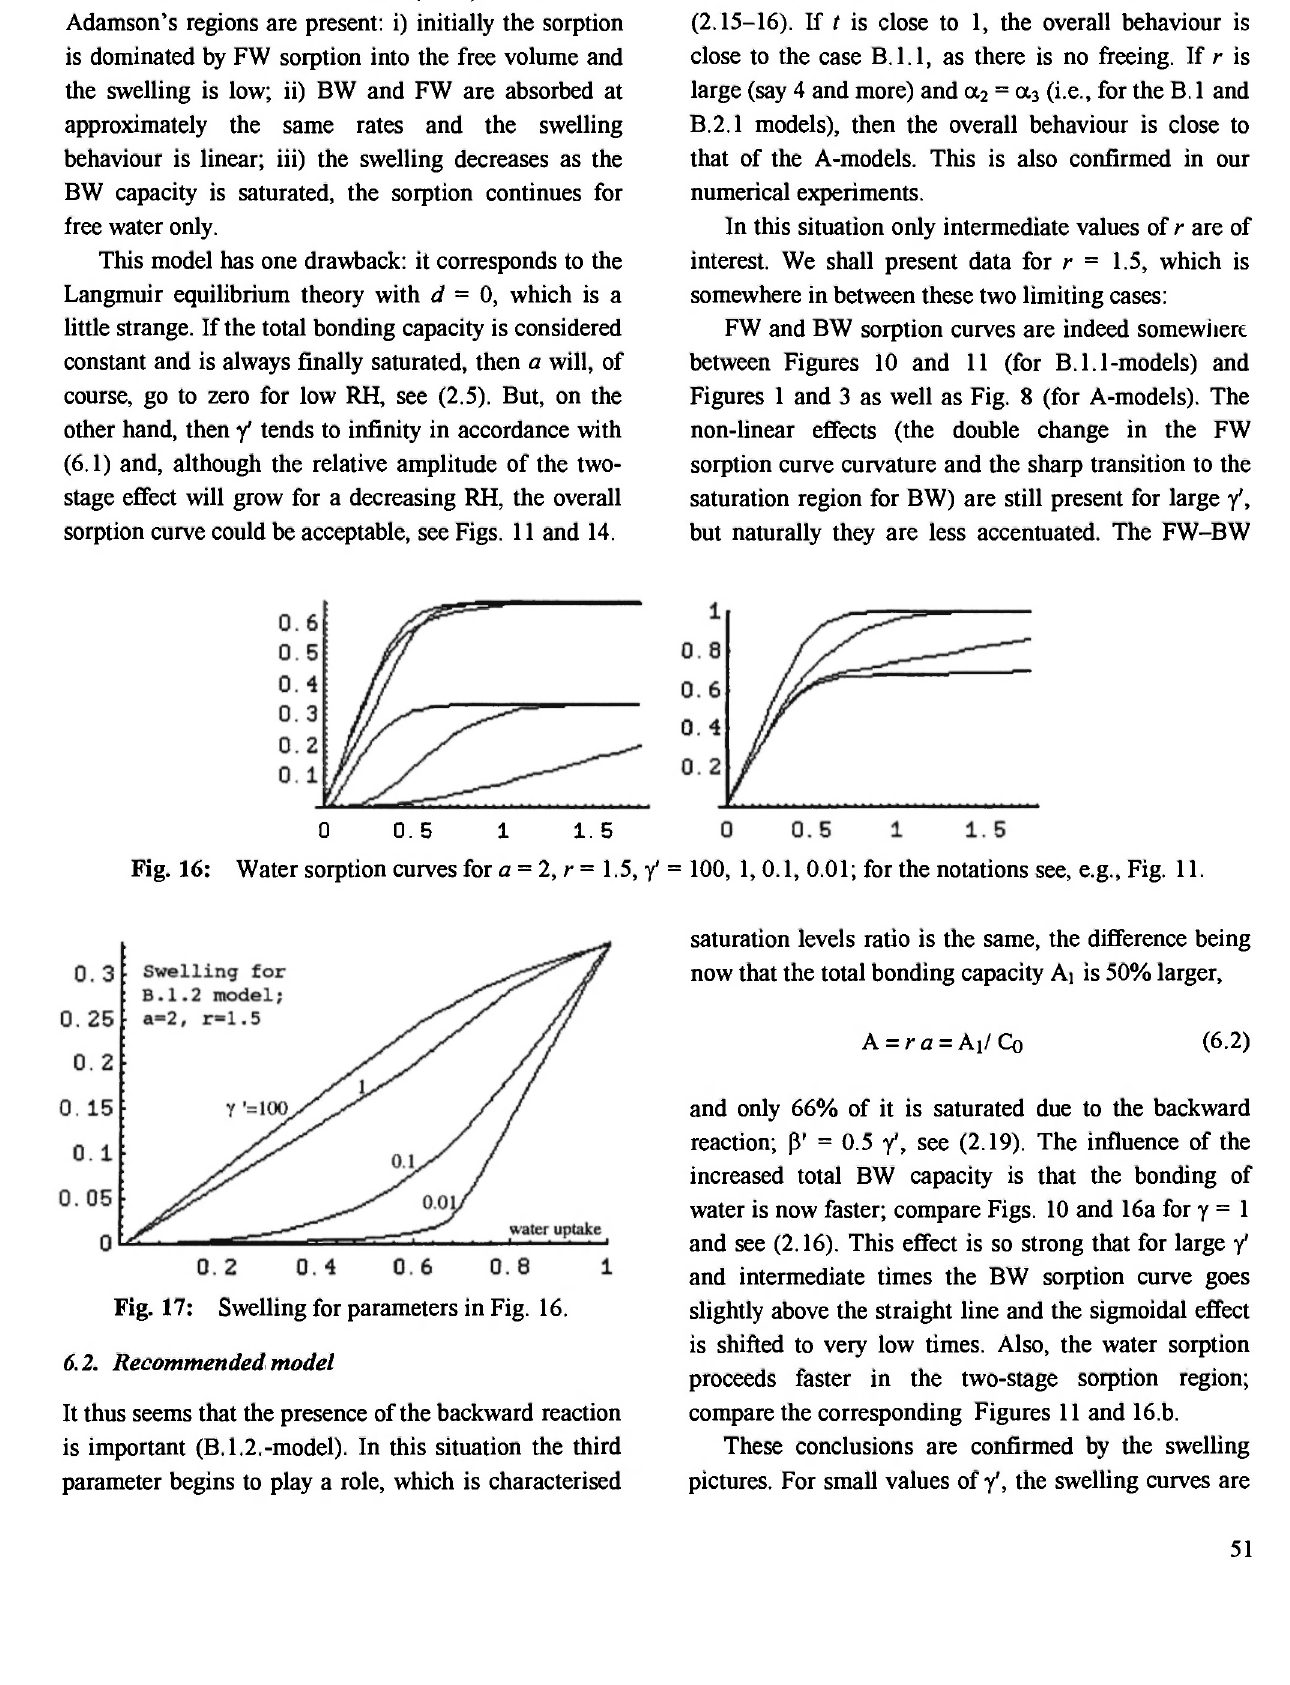
Fig. 17: Swelling for parameters in Fig.